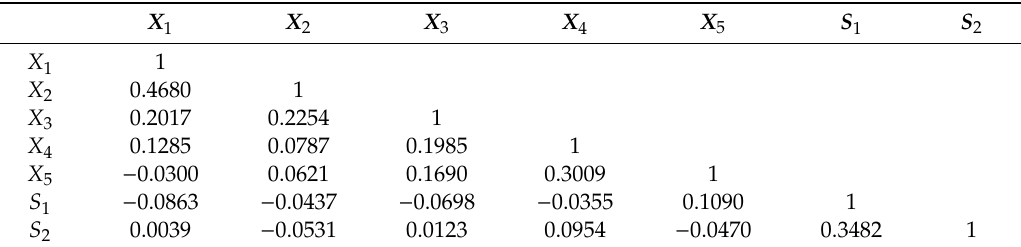
Table 6. Spearman’s Rank correlation matrix of the original survey